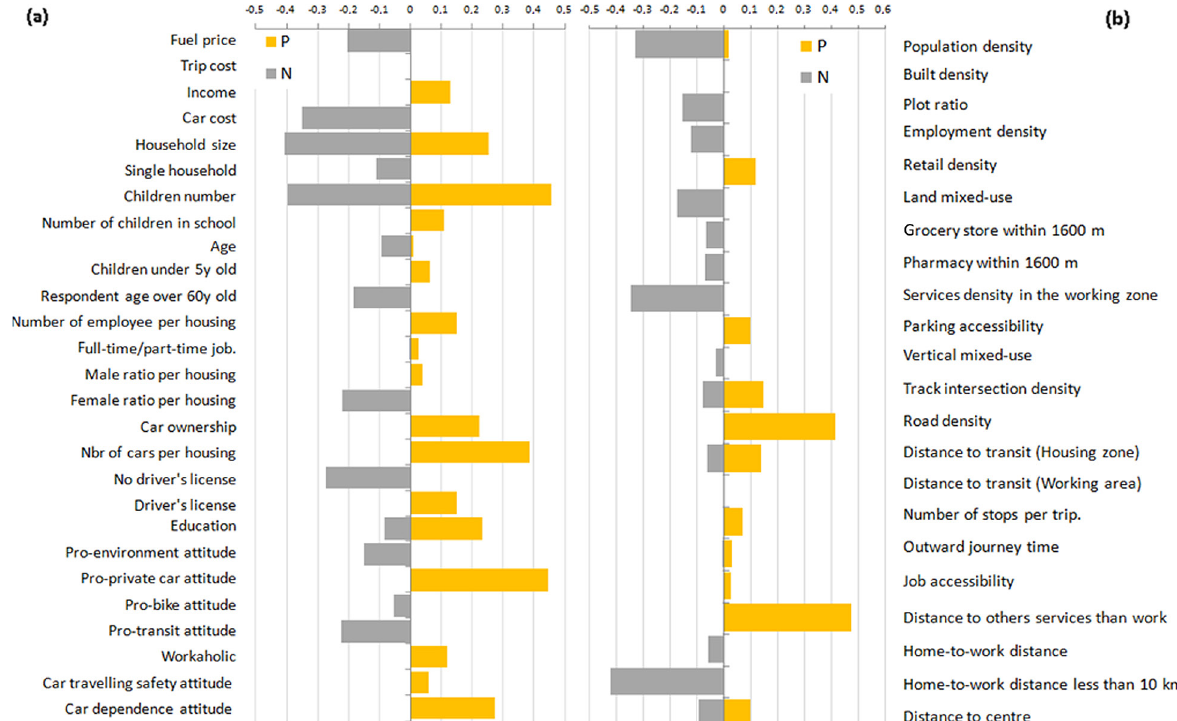
fig. 4. Maximum values ( B standardised) for the impact of the drivers related to: (a) – socio-economic characteristics of households, (b) – the built environment. P – positive; N – negative. Source: own